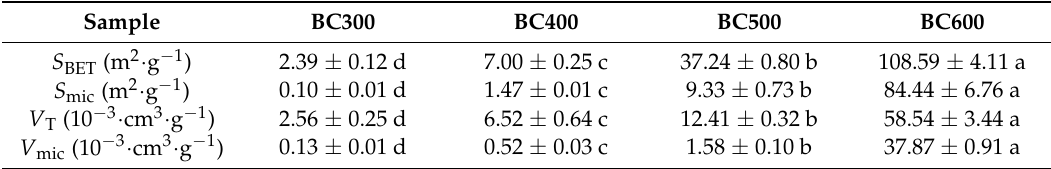
Table 2. Surface area and pore volumes of biochars produced at different temperatures.